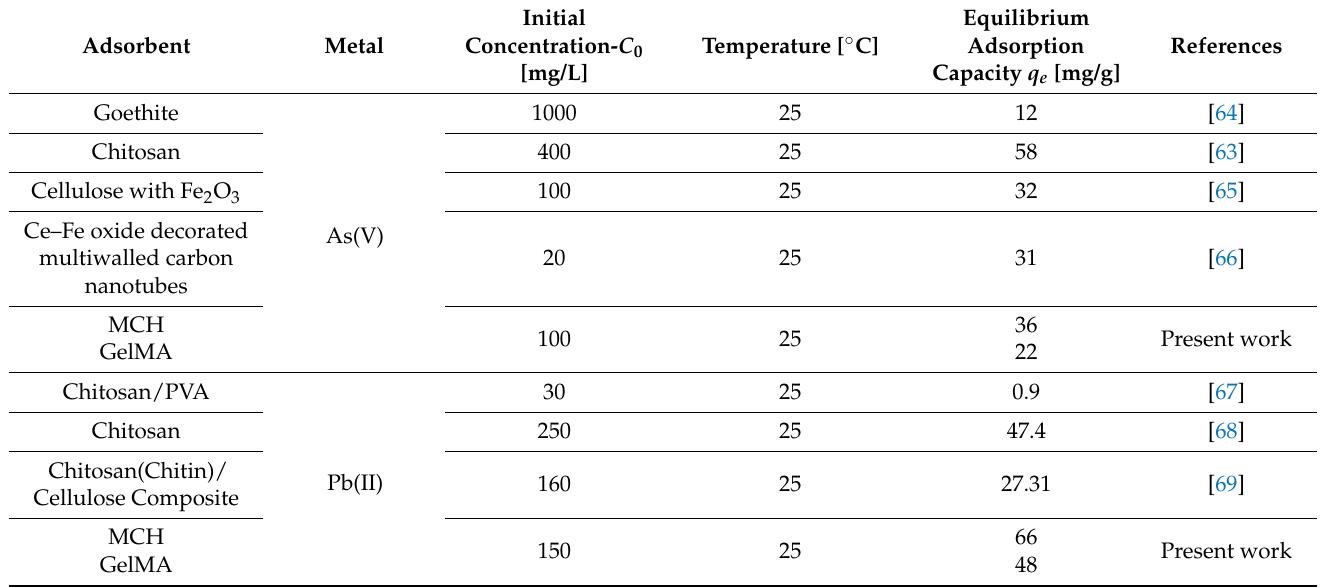
Figure 11. ( a ) Isotherm plots of MCH and GelMA hydrogels obtained from the experimental data; ( b ) removal percentage R(%) of Pb(II) by MCH and GelMA at different initial concentration. Table 5. Maximum As(V) and Pb(II) equilibrium adsorption capacity of different adsorbents reported in the literature.